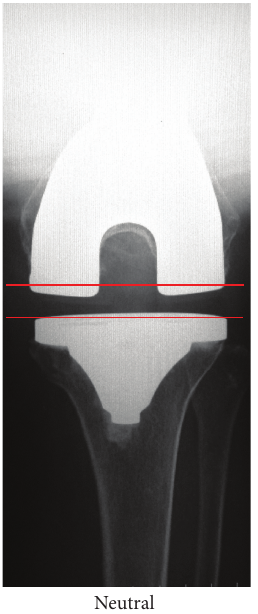
Figure 2: Postoperative axial radiographs of the left distal femur. Patients sit on a table with their lower legs dependent and a 1.5 kg weight attached to the ankle on the treated side. The angle between the cut lines of the posterior femoral condyles and the proximal tibia represents the flexion gap balance